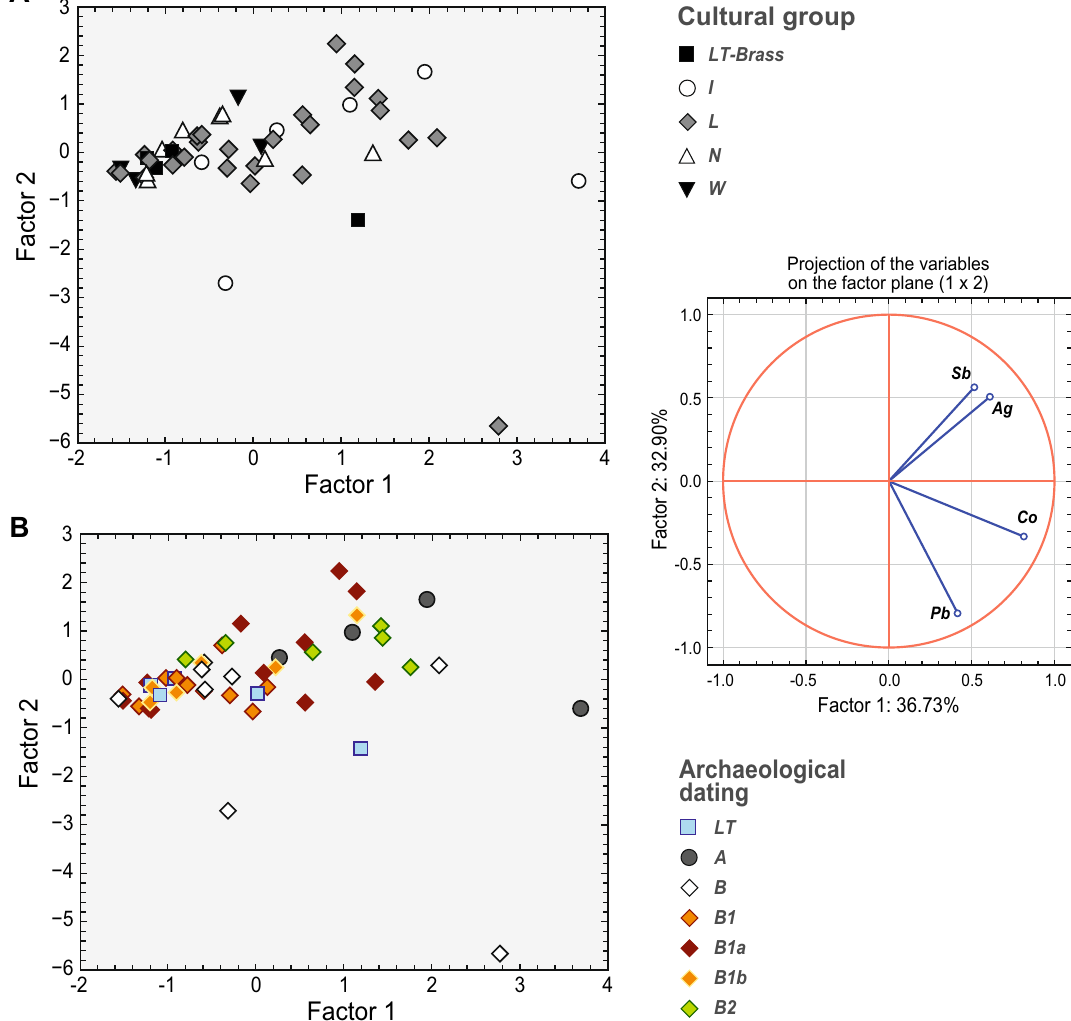
Figure 4. Plot with results of principal component analysis based on minor/trace elements (Pb, Co, Sb, Ag) for the Bohemian brass artefacts from this study. Factor 1 versus Factor 2 is categorised according to the cultural groups ( A ) and dating ( B ). The inset panel shows variables factor